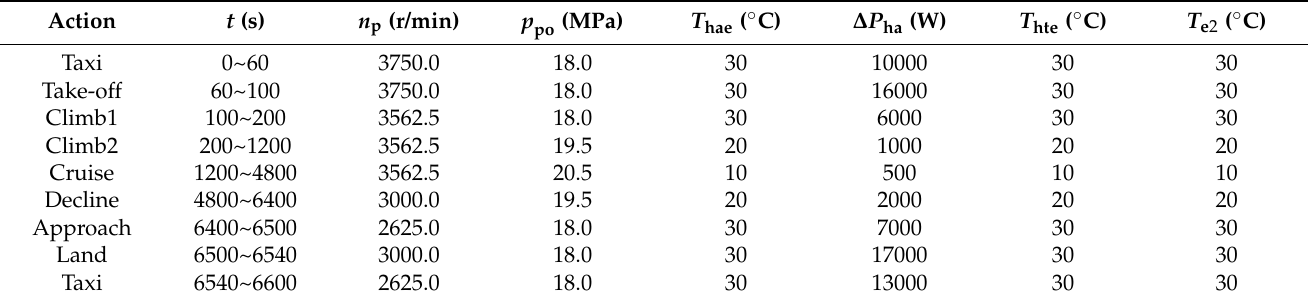
Table 2. Physical variables of the components and subsystems in a flight mission profile.